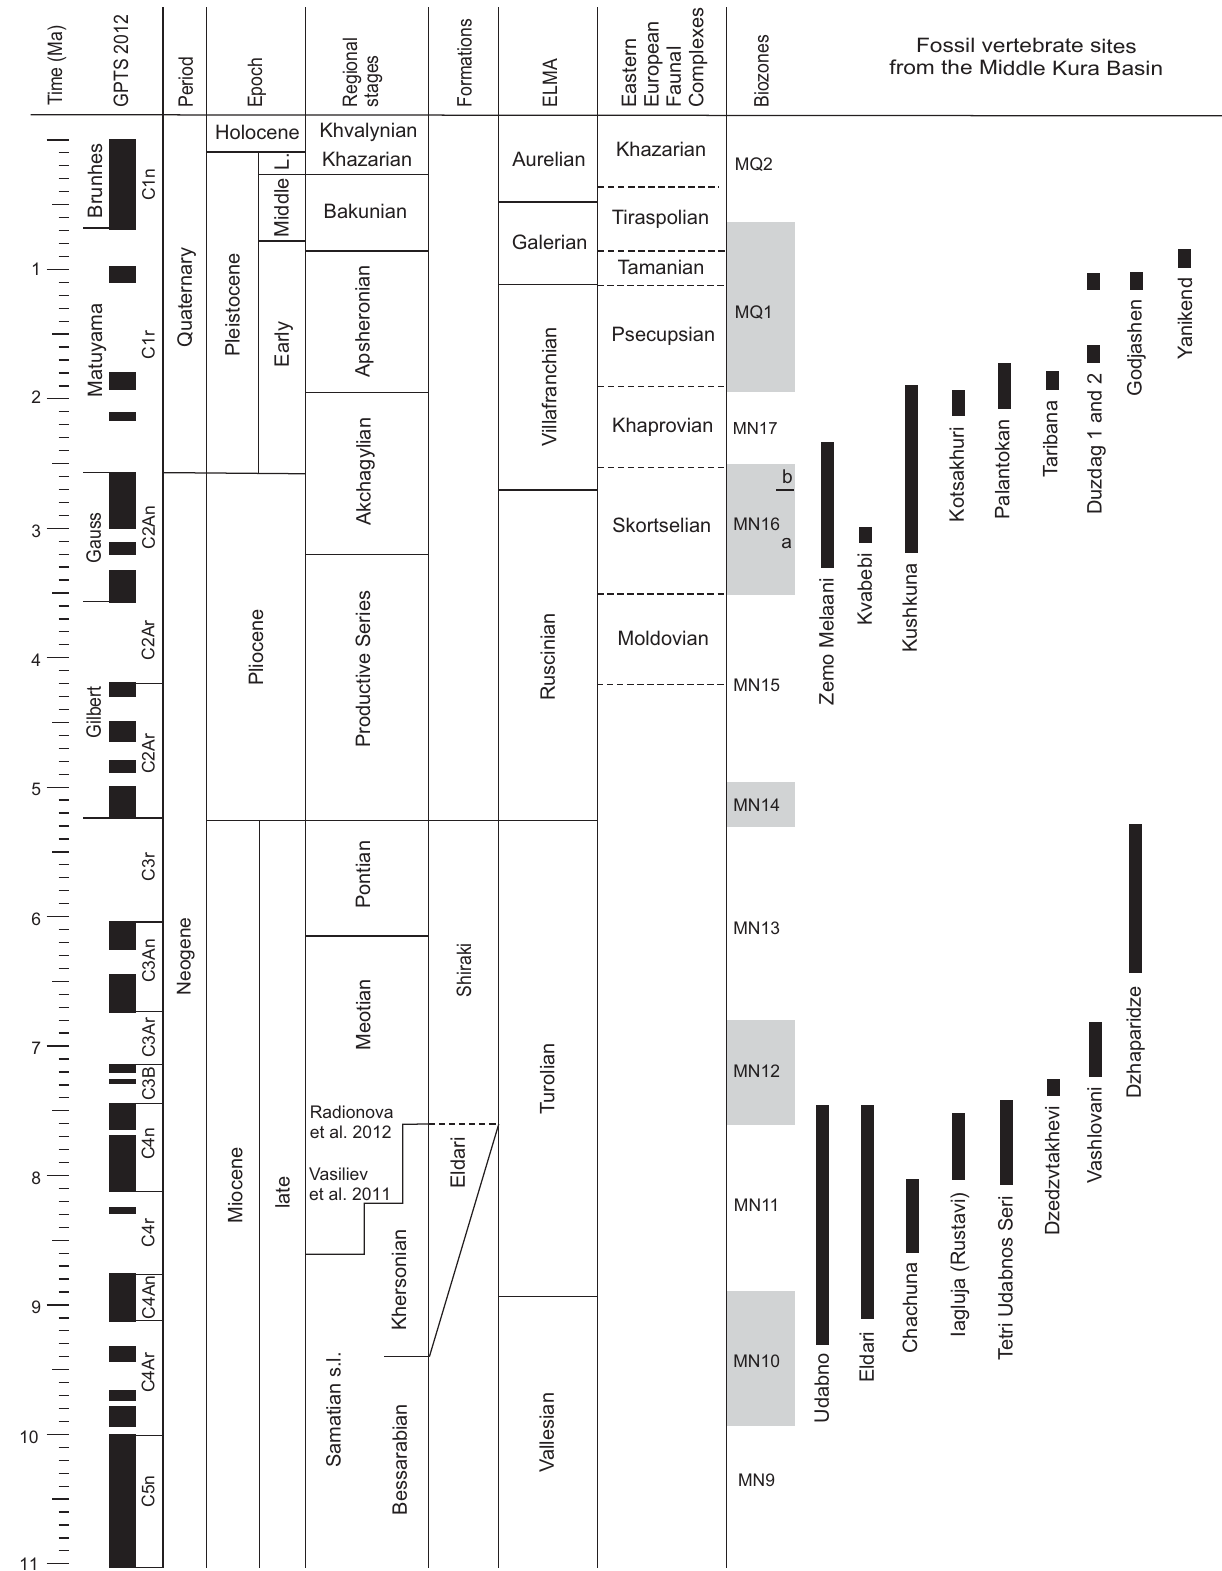
Fig. 5. Tentative correlations of the Middle Kura Basin fossil vertebrate sites. Geomagnetic Polarity Time scale (GPTS) according to Ogg (2012). Regional stages: Vasiliev et al. (2011), Radionova et al. (2012), Van Baak et al. (2012). Boundaries between geological formations: Buleishvili (1960), Vangengeim and Tesakov (2008). European Land Mammal Ages (ELMA): Hilgen et al. (2012), Nomade et al. (2014). Eastern European Faunal Complexes: Vislobokova (2008), Vislobokova and Tesakov (2013). Biozones: Hilgen et al.